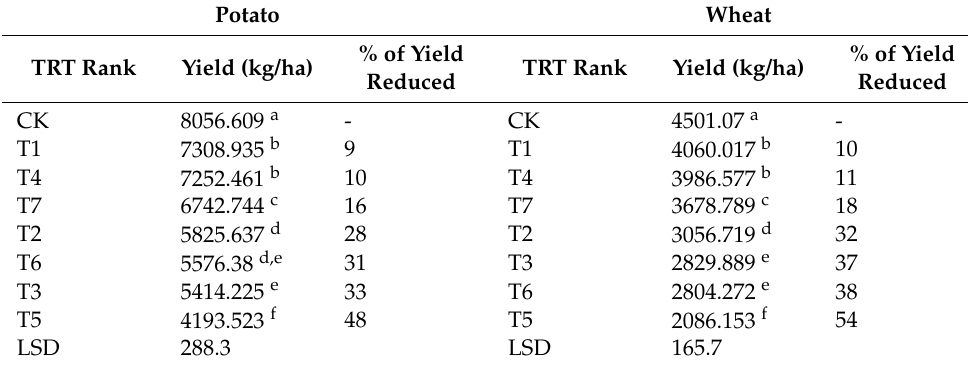
Figure 6. Coupling degree between P e and ET c in the irrigation season: ( a ) potato, ( b ) wheat. Table 4. Statistical analysis of SWAT simulated yield. Potato